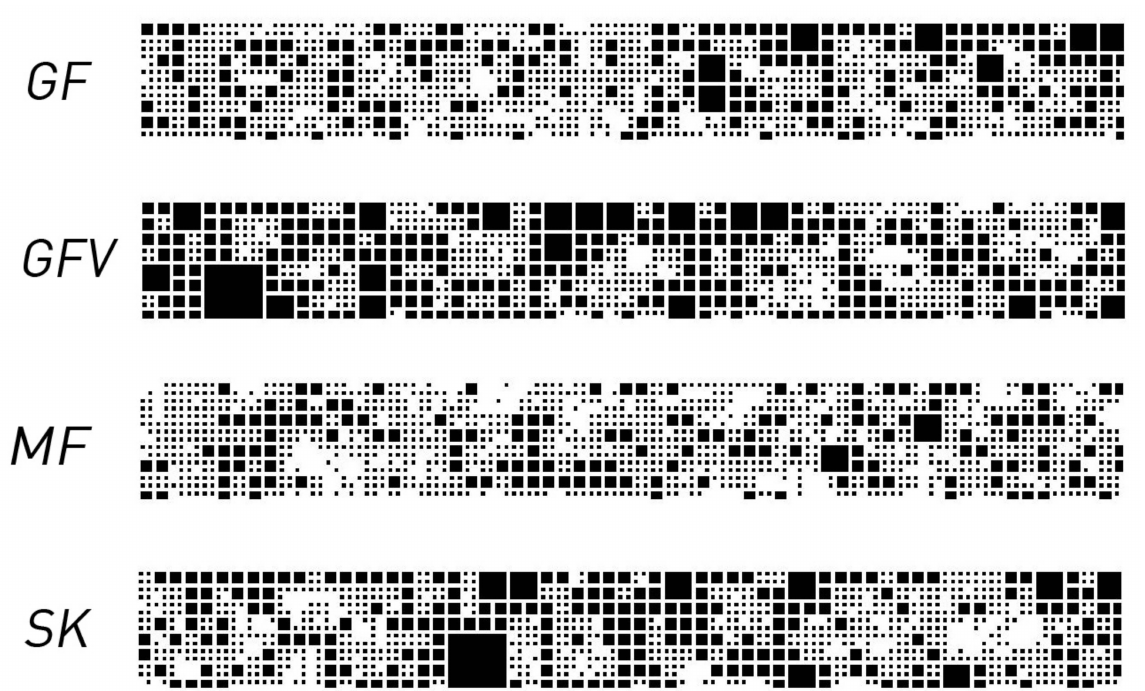
Figure 6. Graphic interpretation of the results of square-tree decomposition of the tested choco- late